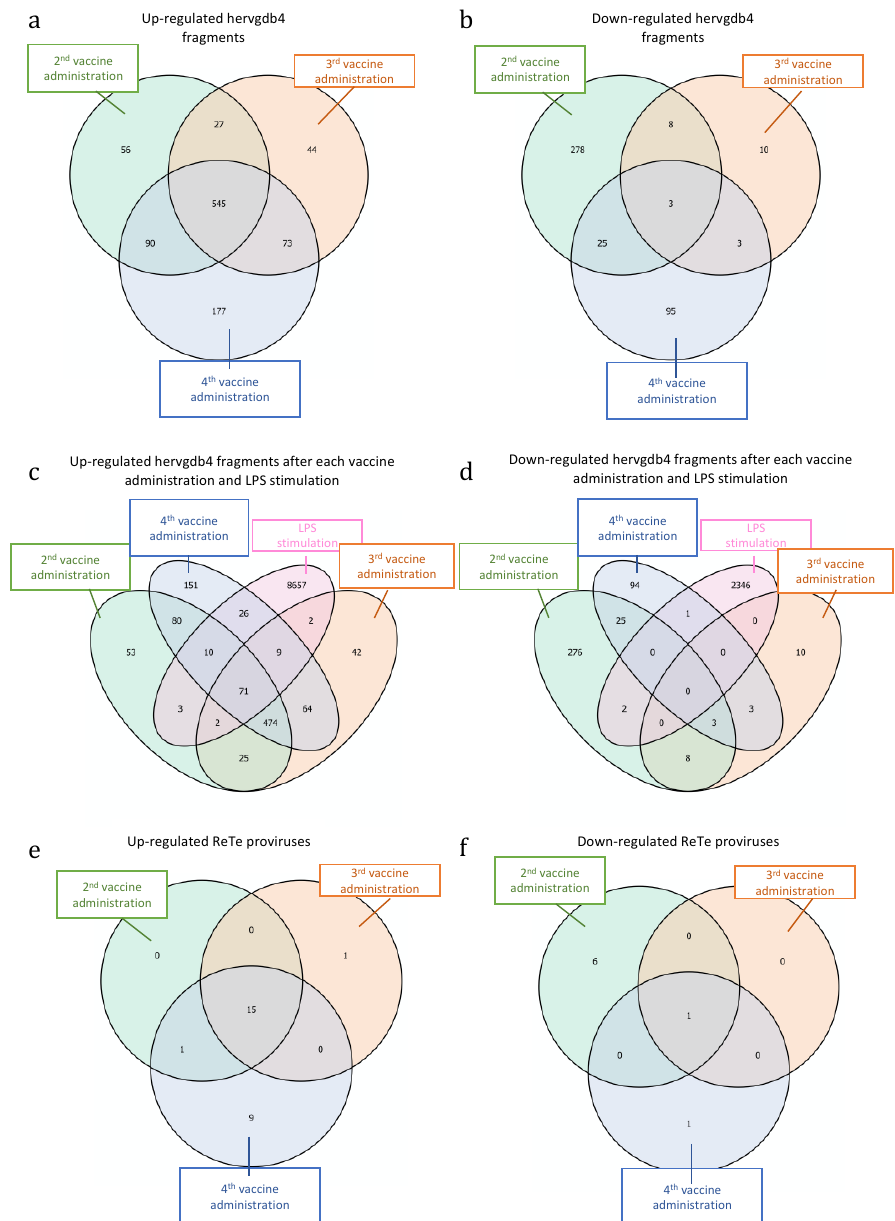
Figure 6. Differentially expressed HERVs and MaLR after each vaccine administration and LPS stimulation. Intersections of up-regulated ( a ) and down-regulated ( b ) hervgdb4 fragments after each vaccine administration. Intersection of up-regulated ( c ) and down-regulated ( d ) hervgdb4 fragments after each vaccine administrations and after LPS stimulation (data from Pisano et al. 2019 [32]). Up-regulated ( e ) and down-regulated ( f ) ReTe proviruses after all the vaccine admin- istrations. Table 3. Description of the 16 ReTe proviruses differentially expressed after all vaccine admin-